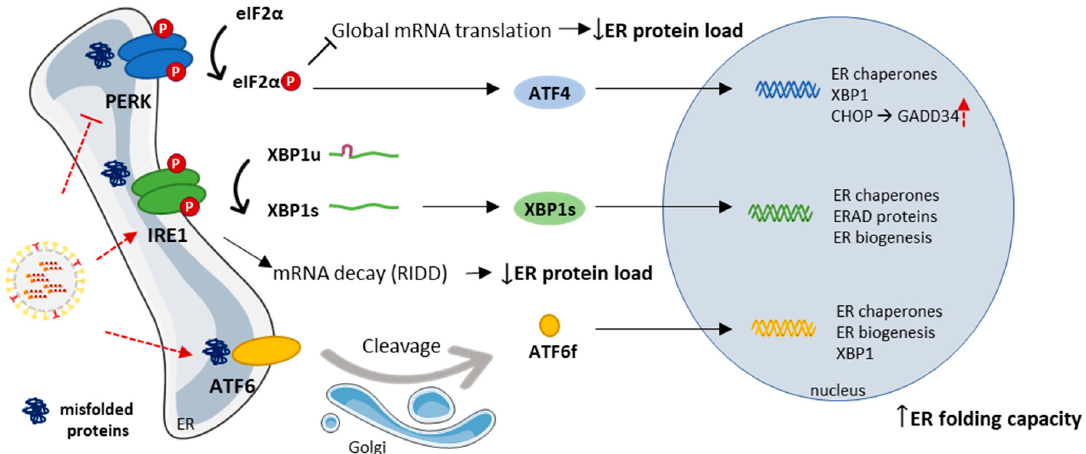
Figure 4. Schematic representation of the three main branches of unfolded protein response (UPR) in the ER (PERK, IRE1, and ATF6). In normal conditions, the activation of UPR helps to diminish ER stress by reducing ER protein load and increasing ER folding capacity. To evade the antiviral effects of PKR, the viral NS1 has been shown to inhibit protein kinase R (PKR) activity, which in turn will affect the PERK-induced response. Previous reports, although contradictory, also demonstrate that upon infection the virus can to some extent influence the mediated signaling of the three UPR branches. Red dotted arrows represent still controversial actions of IAV on UPR targets. Viral proteins are represented underlined.